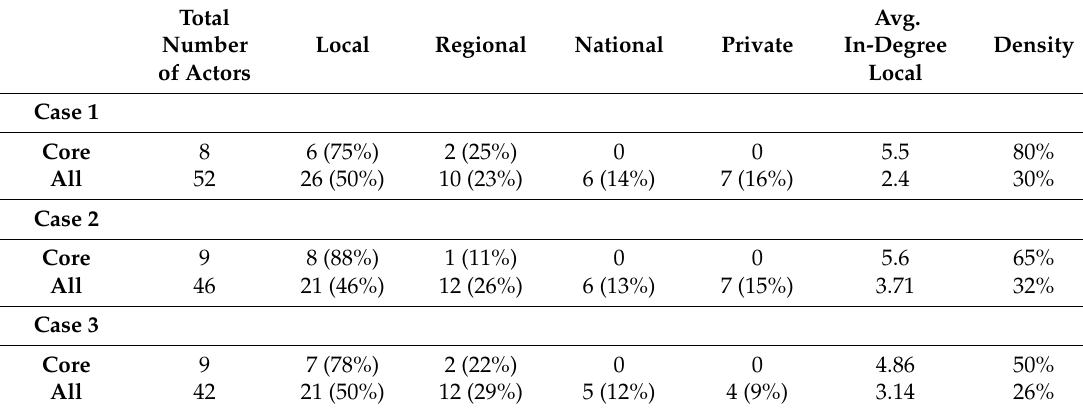
Table 4. Reputational power in three